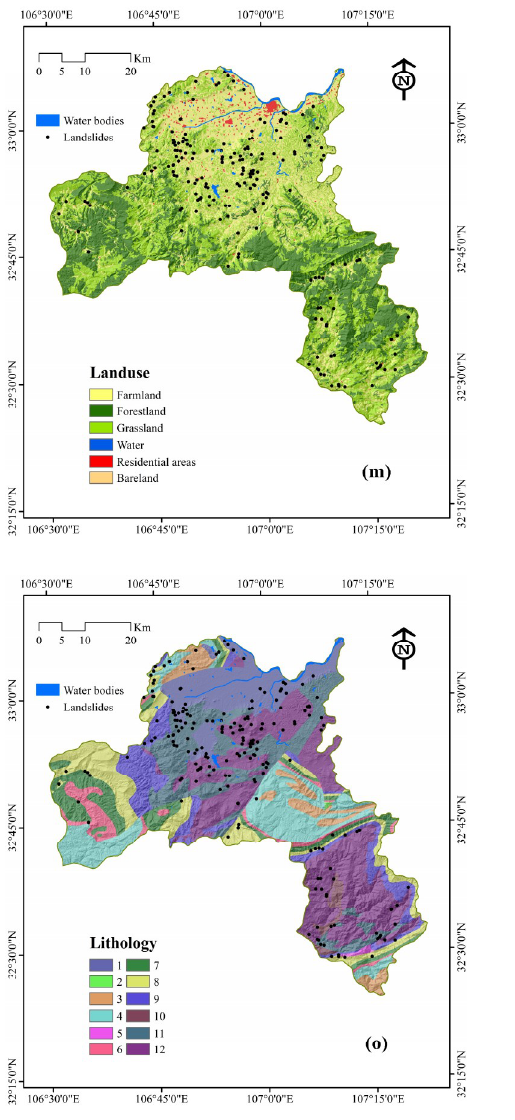
Figure 3. Thematic maps: ( a ) Slope angle; ( b ) Slope aspect; ( c ) Elevation; ( d ) Plan curvature; ( e ) Profile curvature; ( f ) TWI; ( g ) SPI; ( h ) STI; ( i ) Distance to rivers; ( j ) Distance to roads; ( k ) Distance to faults; ( l ) Soil; ( m ) Land use; ( n ) NDVI; ( o ) Lithology; and ( p ) Rainfall.